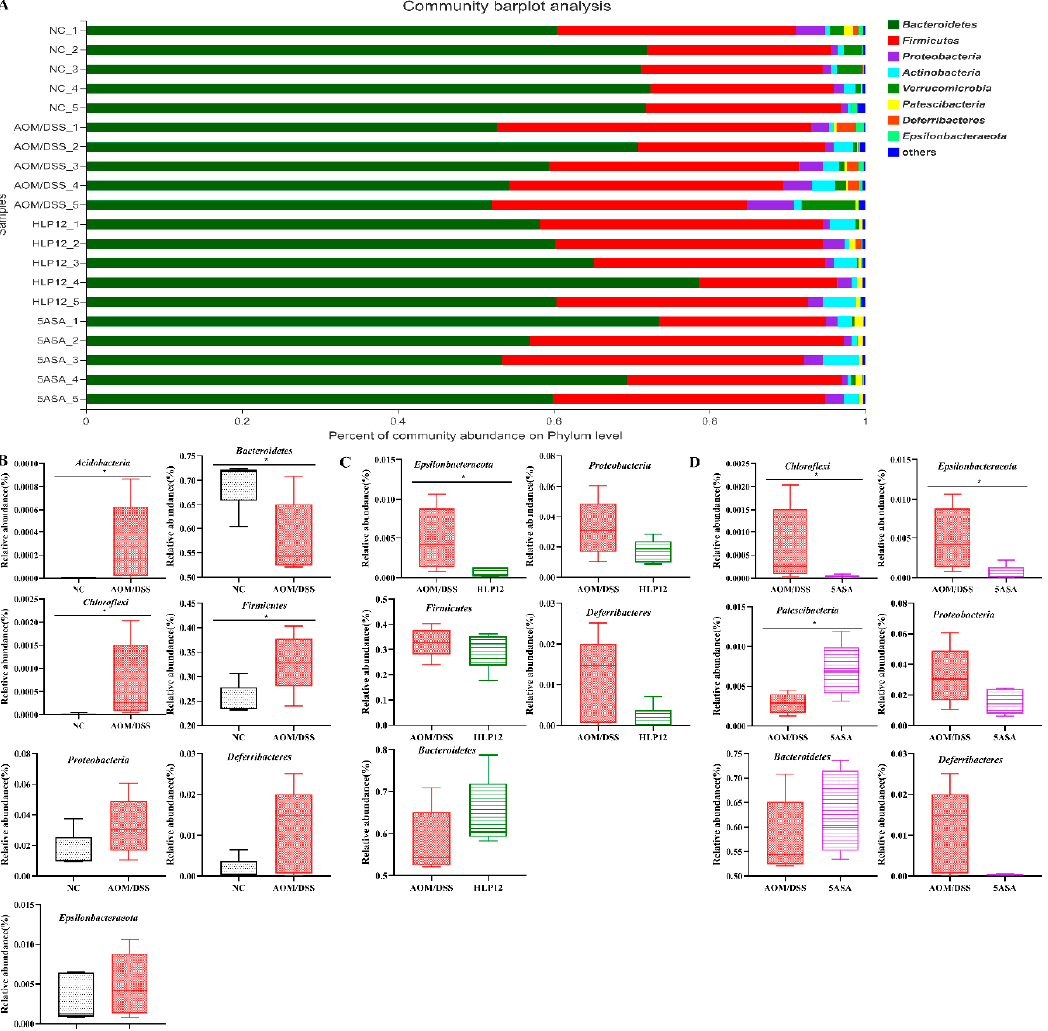
Figure 8. Effect of L. plantarum -12 oral administration on intestinal microbiota at the phylum level of AOM/DSS-treated mice ( n = 5). ( A ) Bar picture, ( B ) NC vs. AOM/DSS species difference analysis, ( C ) AOM/DSS vs. HLP12 species difference analysis, and ( D ) AOM/DSS vs. 5ASA species difference analysis. * p <